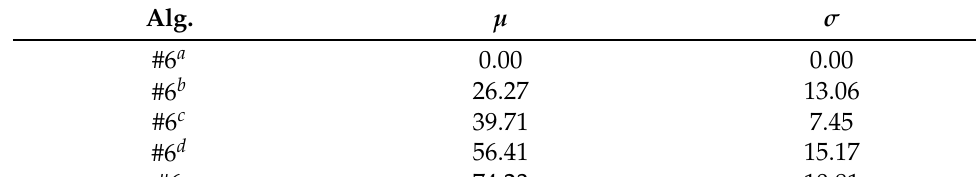
Table 4. Average percentage of pairwise mappings removed by each algorithm.